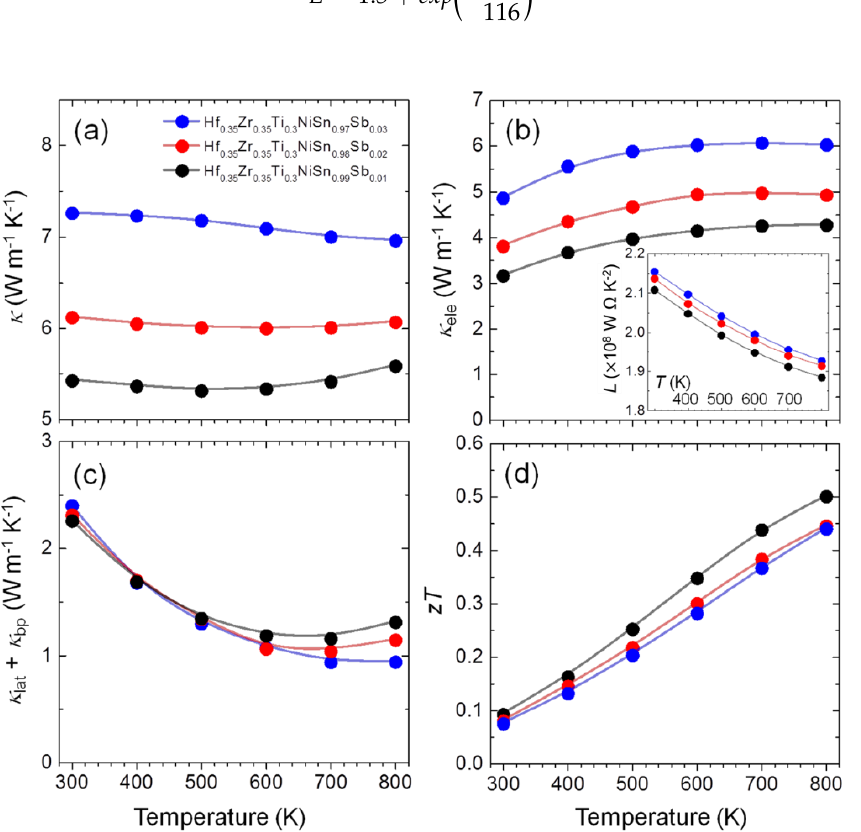
Figure 4. Temperature dependence of ( a ) total thermal conductivity, ( b ) electronic thermal conductivity, ( c ) lattice and bipolar thermal conductivity, and ( d ) dimensionless figure of merit for SPSed bulks of Hf 0.35 Zr 0.35 Ti 0.3 NiSn 1 − x Sb x ( x = 0, 0.01, 0.02, 0.03). Inset of ( b ) is the temperature-dependent Lorenz number.